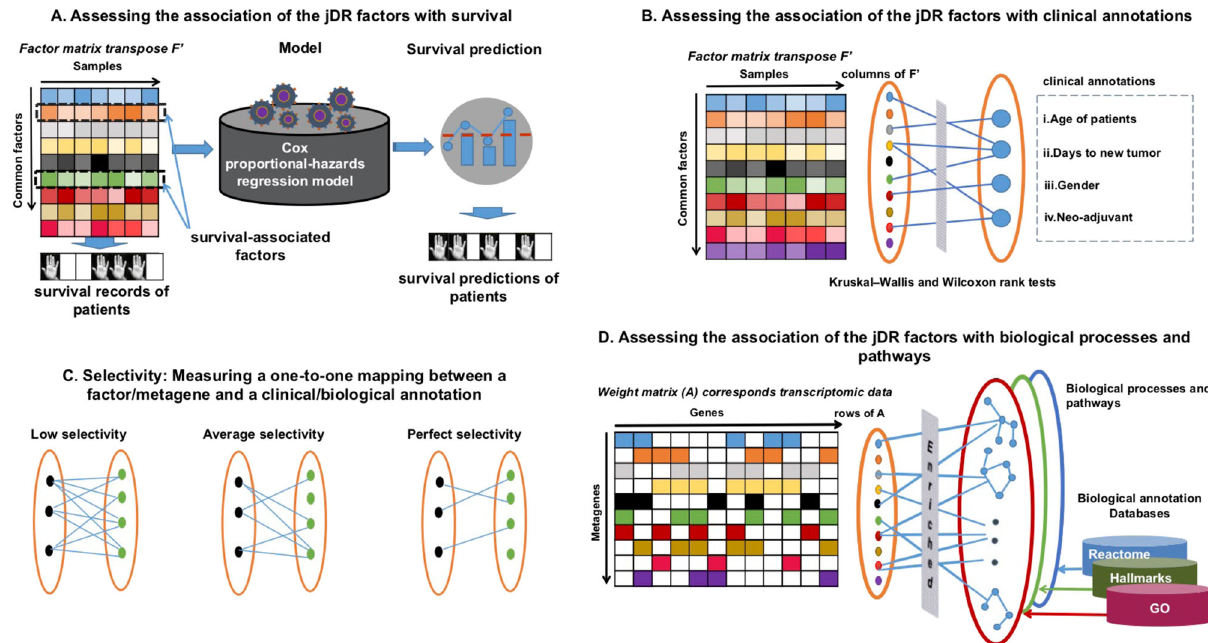
Fig. 4 graphic summary of the cancer sub-benchmark. a Testing the association of jDR factors with survival; b Testing the association of jDR factors with clinical annotations; c Graphical explanation of the selectivity score: measuring the one-to-one mapping between factors and clinical/biological annotations; d Testing association of jDR factors with biological processes and pathways.